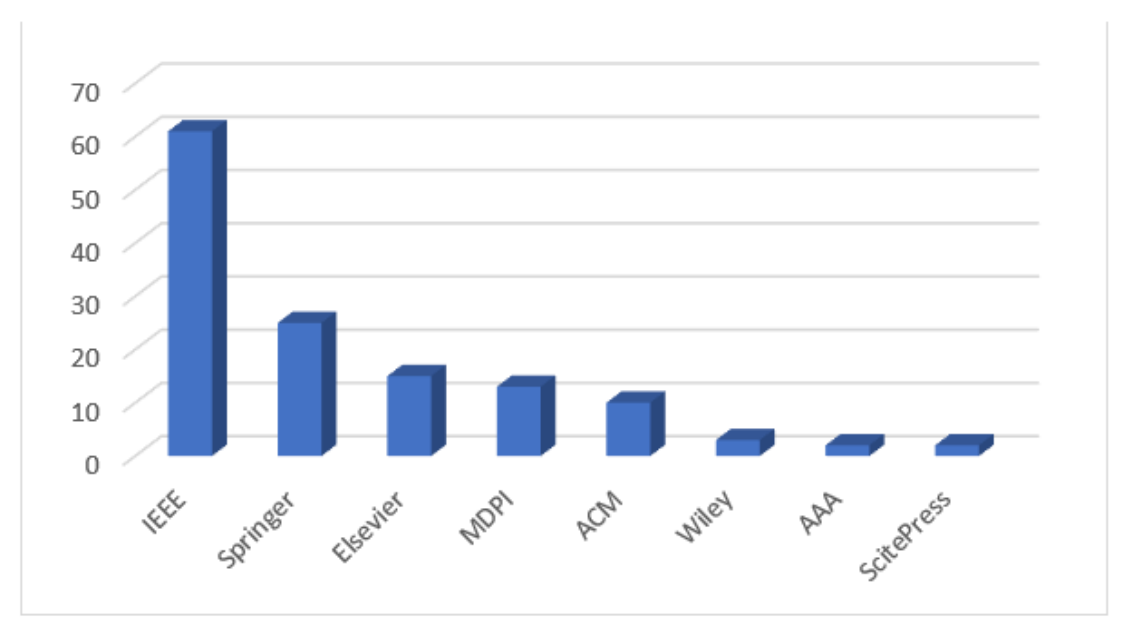
Figure 5. Documents by publisher. Table 7. Distribution by category and article